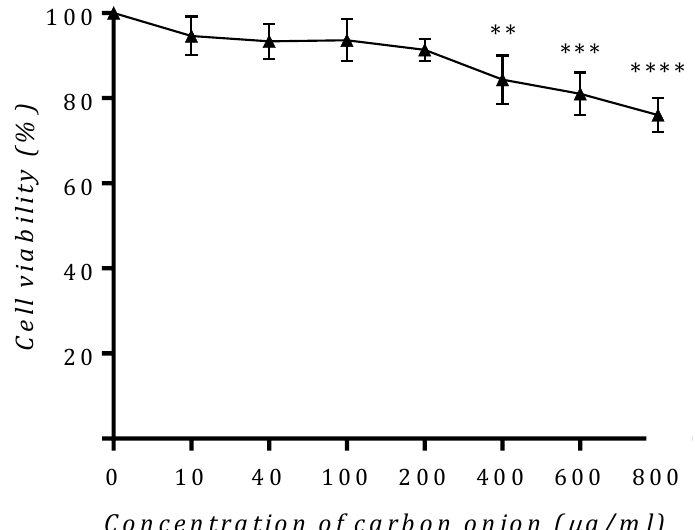
Figure 11. Cytotoxicity of carbon onion against Caco-2 cells. MTT assay was used to analyse the survival rate of Caco-2 cells incubated with different concentrations of carbon onion. Statistically significant differences compared to control (0 µg/mL) are noted for P < 0.05 (** P < 0.01; *** P < 0.001; **** P < 0.0001, one-way ANOVA and Dunnett’s multiple comparison test). Results are the mean of triplicate experiments ± SD.